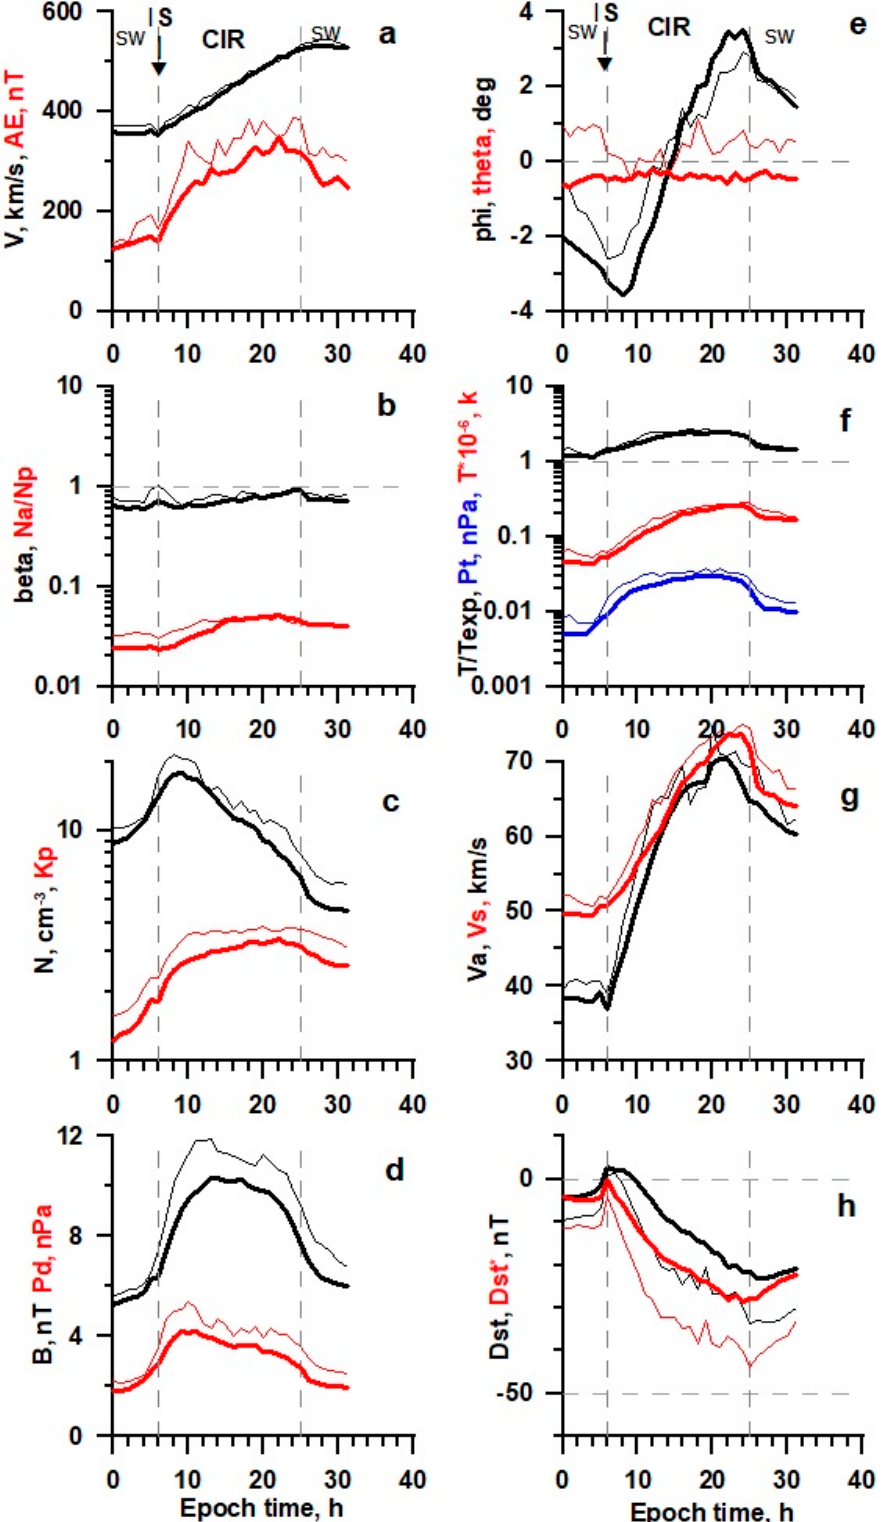
Figure 2. The temporal profile of solar wind and IMF parameters (see legend in the text) for IS/CIR obtained by the double superposed epoch analysis for 127 events in 21–22 SCs (thin lines) and 539 events in 23–24 SCs (thick